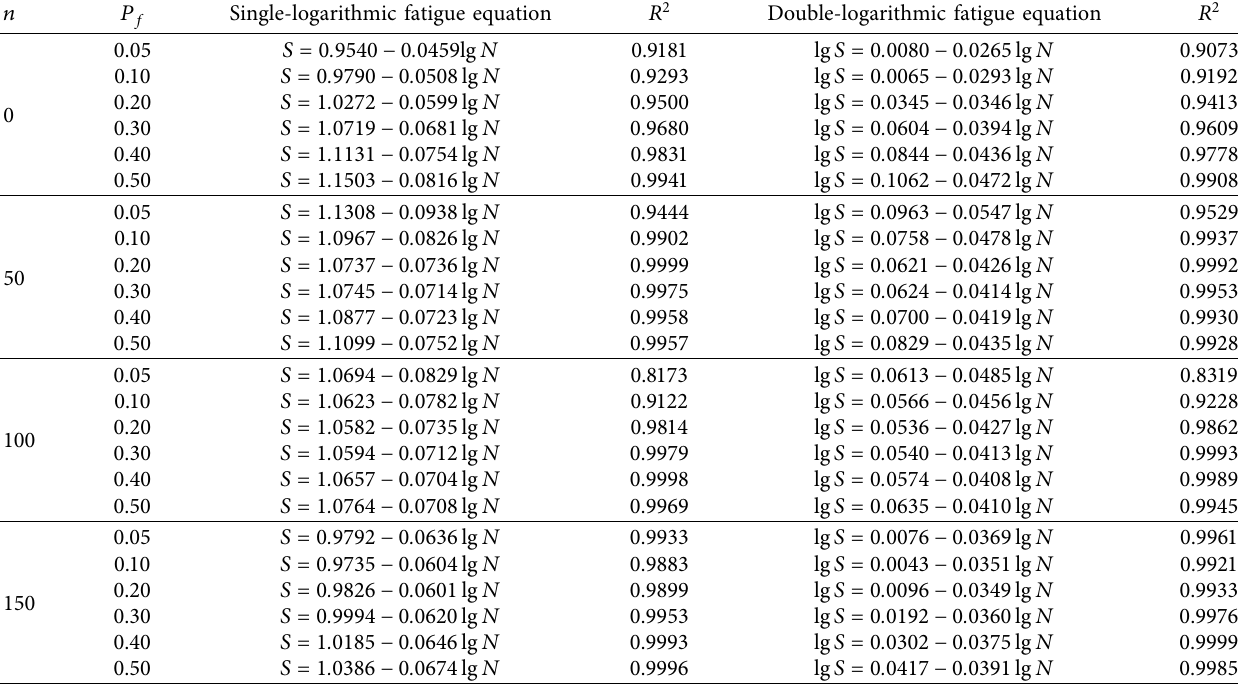
Table 14: Single-logarithmic and double-logarithmic fatigue equations of AASC with various degrees of frost damage for various failure